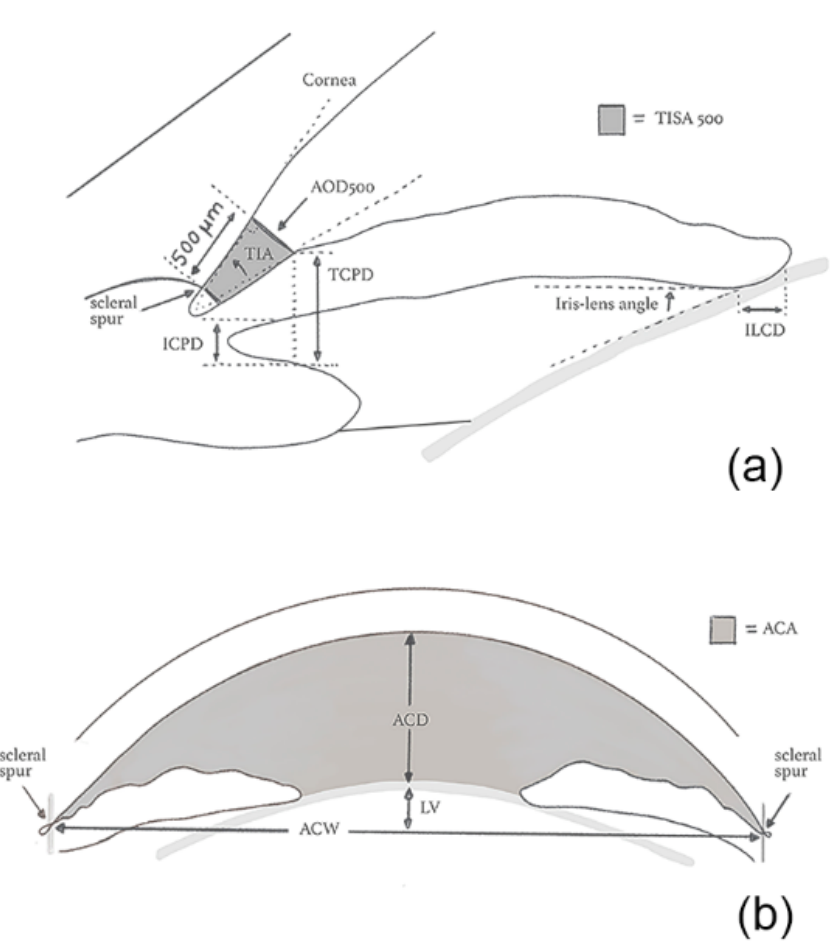
Figure 1. Quantitative parameters of the irido-corneal angle ( a ) and of the anterior chamber ( b ). ACA: Anterior chamber angle; ACD: Anterior chamber depth; ACW: Anterior chamber width; AOD: Angle opening distance; ICPD: Iris-ciliary process distance; ILCD: Iris-lens contact distance; LV: Lens vault; TIA: Trabecular-iris angle; TISA: Trabecular iris space area; TCPD: Trabecular-ciliary process distance.